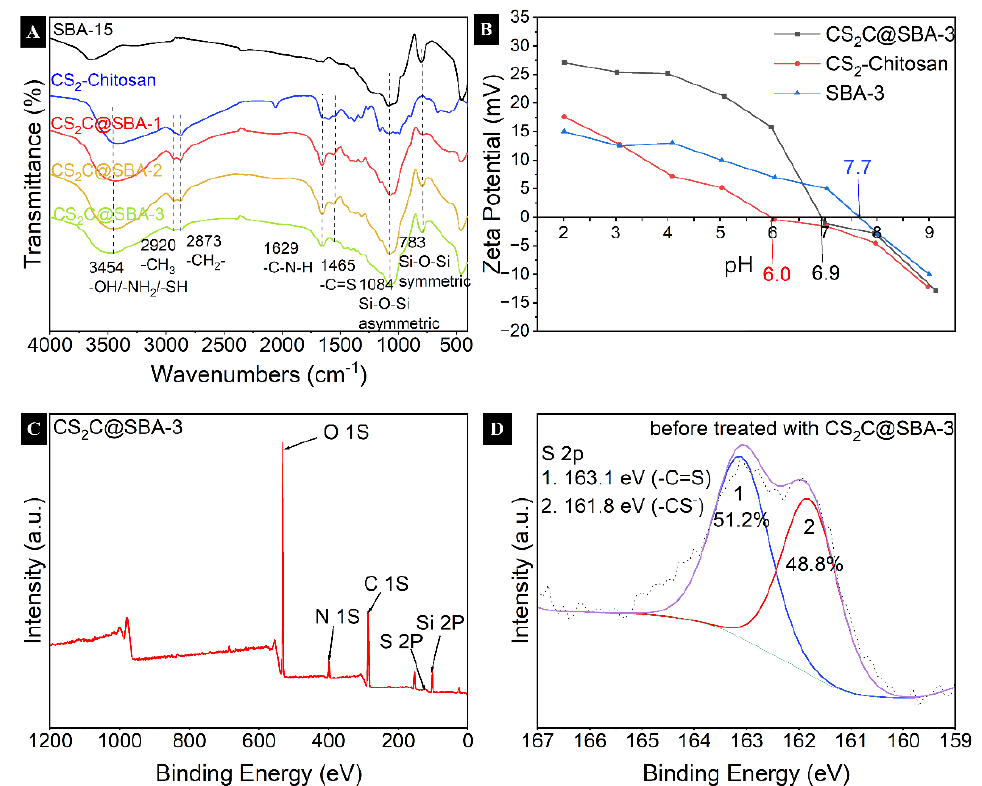
Figure 1. FTIR spectra of synthesized composites ( A ); Zeta potential plots of SBA-15, CS 2 chitosan and CS 2 C@SBA − 3 ( B ). The XPS survey spectra of CS 2 C@SBA − 3 before reaction ( C ). High resolution XPS spectra S 2p of CS 2 C@SBA − 3 ( D ).